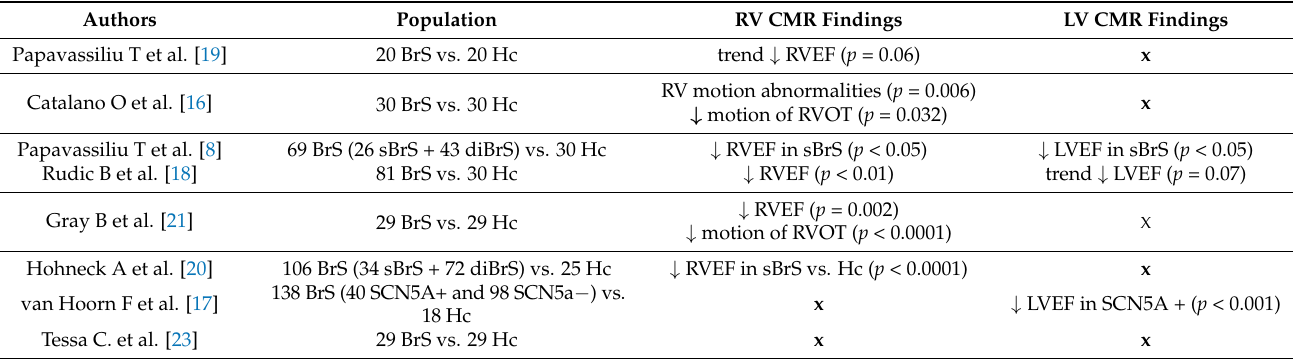
Table 4. CMR findings about RVEF and LVEF in